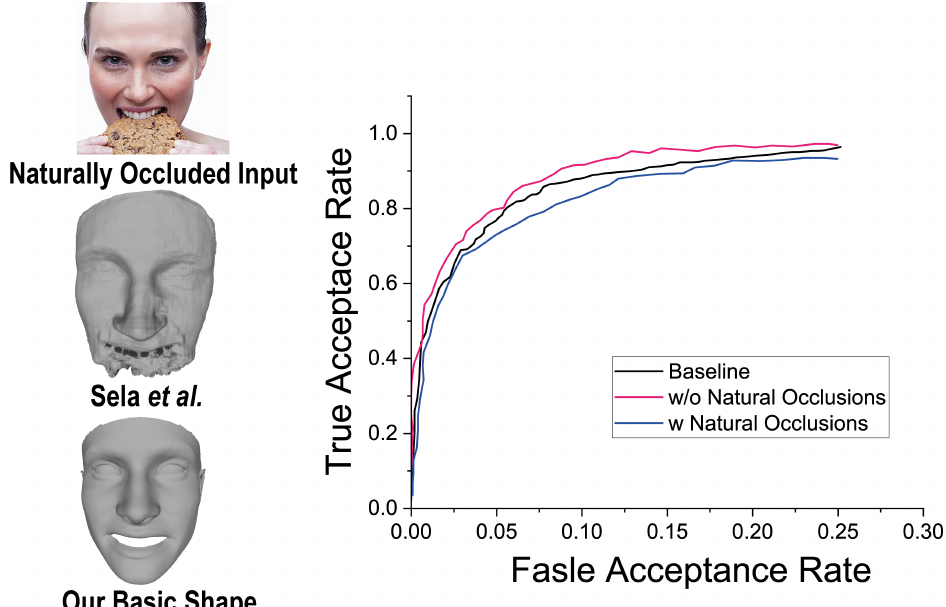
Figure 5. Basic shape reconstructions with natural occlusions.( Left ): Qualitative results of Sela et al. [95], and our shape. ( Right ): LFW verification ROC for the shapes, with and with- out occlusions.